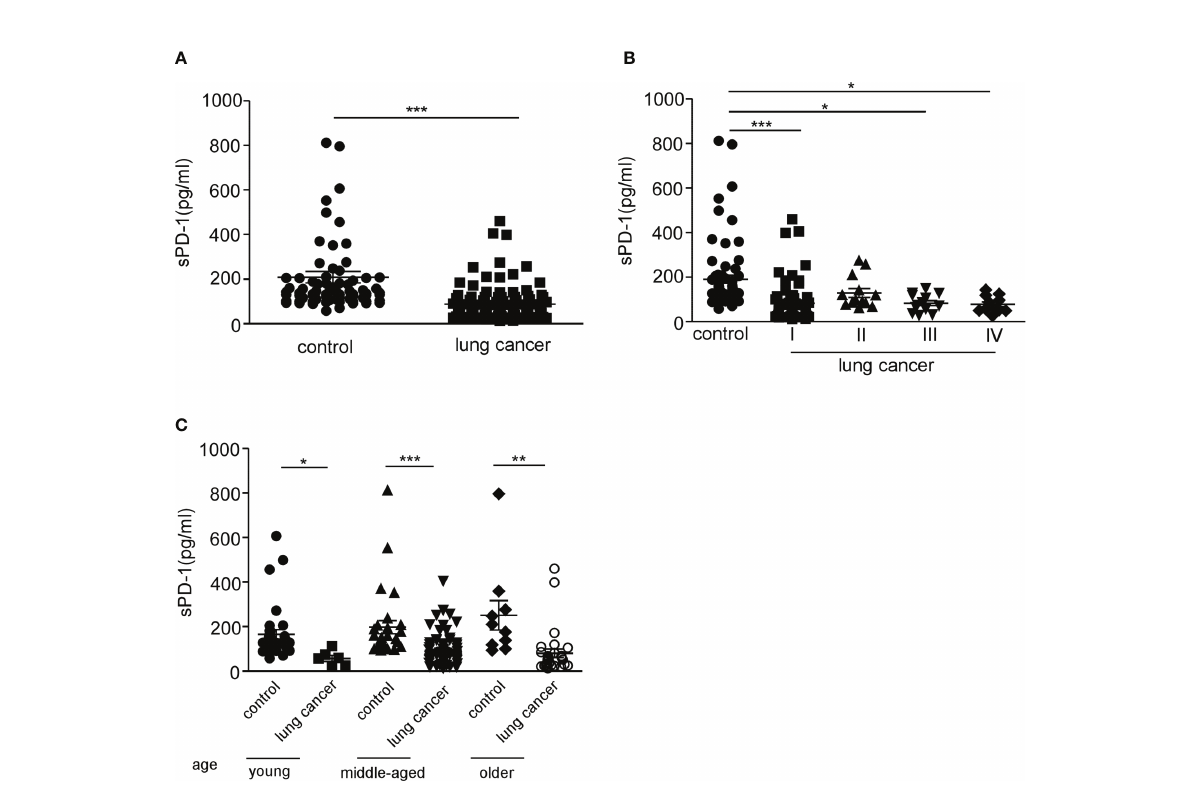
FIGURE 1 Serum sPD-1 level signi fi cantly reduced in lung cancer patients. (A) The serum concentration of soluble PD-1 (pg/ml) was analyzed in non-small cell lung cancer (NSCLC) patients and healthy donor groups by ELISA. (B) The serum levels of sPD-1 (pg/ml) were detected in clinical stage I, stage II, stage III, and stage IV from NSCLC patients by ELISA. (C) The sPD-1 serum levels were analyzed at different age groups of NSCLC patients and control. Young: 22 – 40, middle-aged: 41 – 64, older: 65+ years old. * P < 0.05, ** P < 0.005, *** P < 0.0001. Mann – Whitney test (two- tailed) and non-paired Student ’ s t